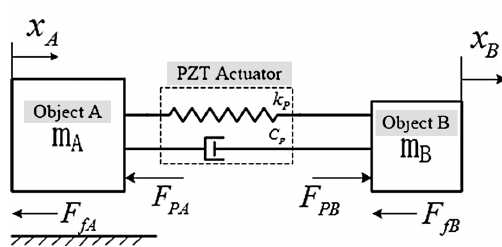
Figure 2. The free-body diagram of the IDM